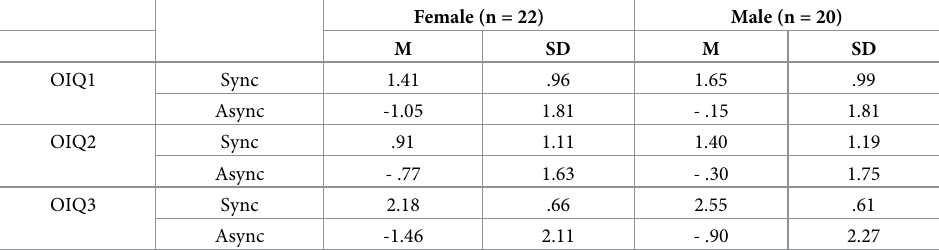
M: mean; SD: standard deviation; OIQ: Ownership Illusion Questionnaire; Participants reported stronger